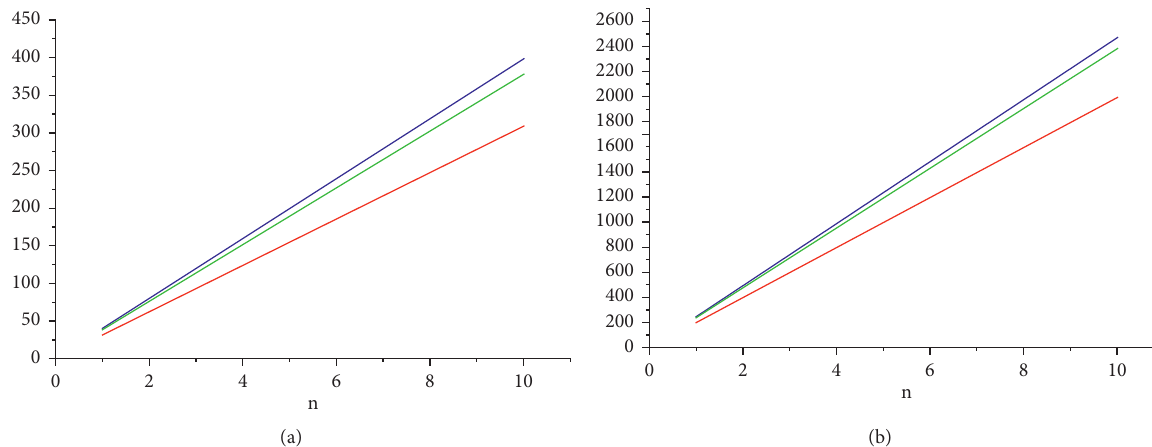
Figure 8: Comparison of GA and GH indices of guar gum, HPG and CMG, and CMHPG. (a) GA (guar gum) in red, GA (HPG and CMG) in green, and GA (CMHPG) in blue; (b) GH (guar gum) in red, GH (HPG and CMG) in green, and GH (CMHPG) in blue.